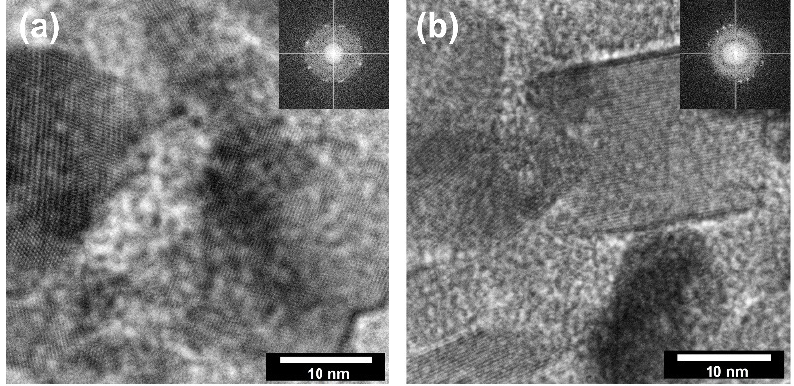
Figure 5. The HR-TEM and FFT images for: ( a ) TiO 2 -(2.5%)ZnO; ( b ) TiO 2 -(20%)ZnO. According to the available scientific literature, the orientation of the growth of crys- talline zinc oxide under certain heat treatment conditions is well defined [44]. Therefore, HR-TEM imaging focused mainly on TiO 2 particles for which the synthesis conditions have a determining the influence on the crystal growth. In HR-TEM and FFT images (Figure 5), TiO 2 particles in TiO 2 -ZnO systems are correctly oriented with respect to the impinging electron beam showing lattice fringes 0.23 nm apart (d 004 = 0.2378 nm) [25]. Thus,